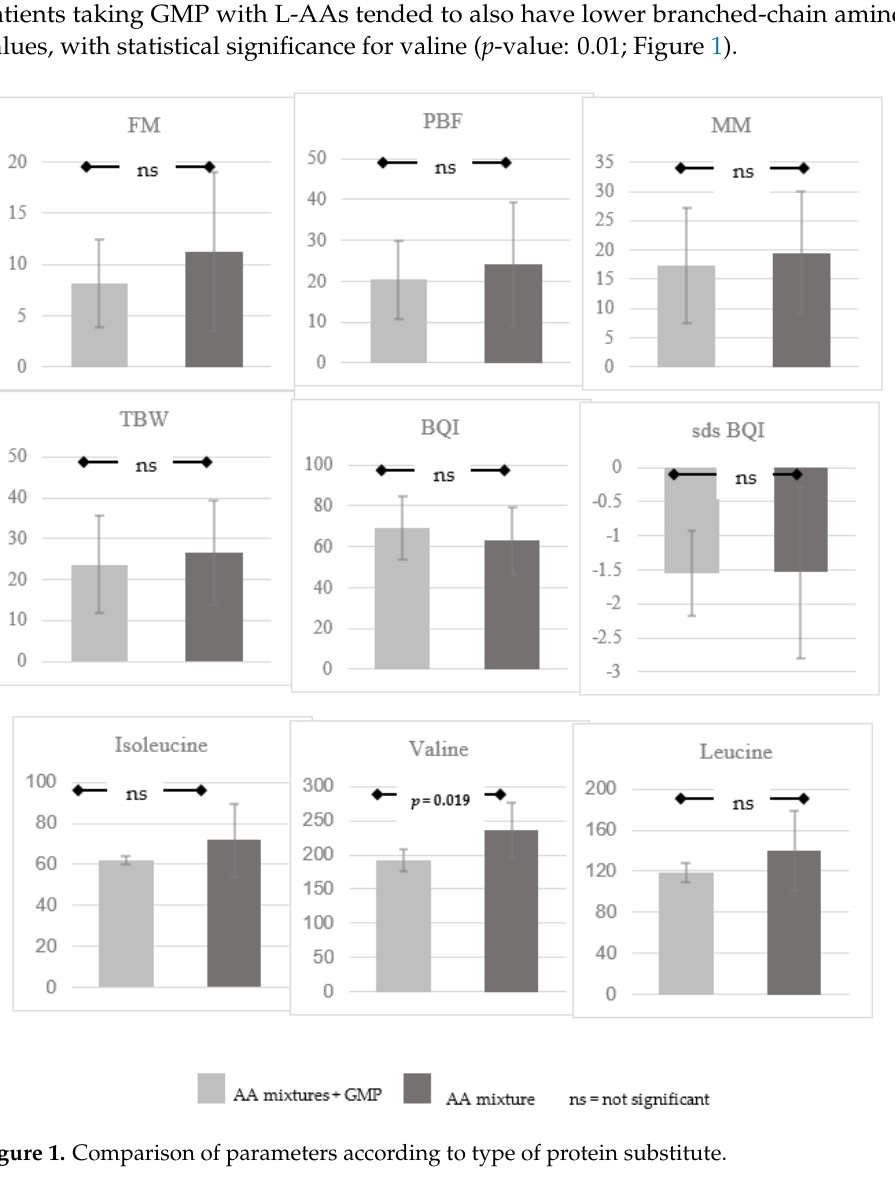
dietary Phe intake (respectively r: 0.47; 0.46) and WHR with increasing mean Phe values (r: 0.43). No significant correlations with the other BIA parameters or with the BQI were retrieved (data not shown). The increase in MM correlated significantly with average Phe values (Figure 2).